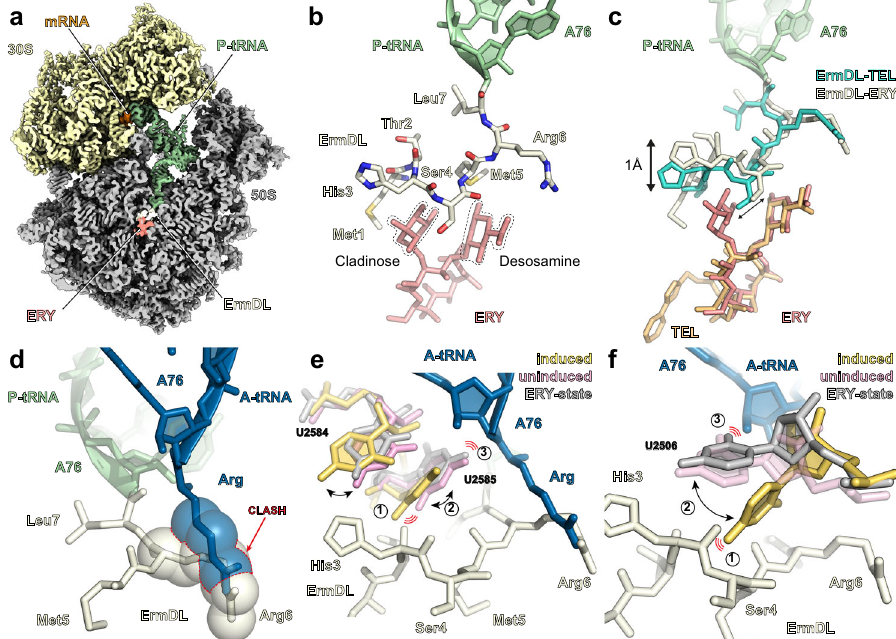
Fig. 5 Cryo-EM structure of ErmDL-ERY-SRC. a Transverse section of the cryo-EM map of the ErmDL-ERY-SRC with isolated densities highlighting the 30S (yellow) and 50S (gray) subunits, P-site tRNA (green), mRNA (orange), ErmDL nascent chain (beige) and erythromycin (ERY, salmon). b Molecular model of the ErmDL nascent chain (beige), P-site tRNA (green) and erythromycin (ERY, salmon). The cladinose and desosamine sugars of ERY are highlighted with dashed line. c Superimposition of ErmDL nascent chains from the ErmDL-ERY-SRC (beige) and ErmDL-TEL-SRC (turquoise). Erythromycin (ERY) and telithromycin (TEL) from the respective structures are shown in salmon and orange. d Superimposition of the ErmDL-ERY-SRC with an A-site Arg-tRNA in silico mutated from the ErmBL A-site Lys-tRNA (blue, PDB 5JTE) 28 , illustrating that Arg6 of ErmDL nascent chain clashes with the Arg8 side chain of the accommodated A-site tRNA. e , f ErmDL stabilizes the uninduced state of the PTC to inhibit A-tRNA accommodation, as evident by comparison of the conformation of e U2584 and U2585 and f U2506 in ErmDL-ERY-SRC (gray) with the uninduced (pink, PDB 1VQN) and induced states (yellow, PDB 1VQ6) 34